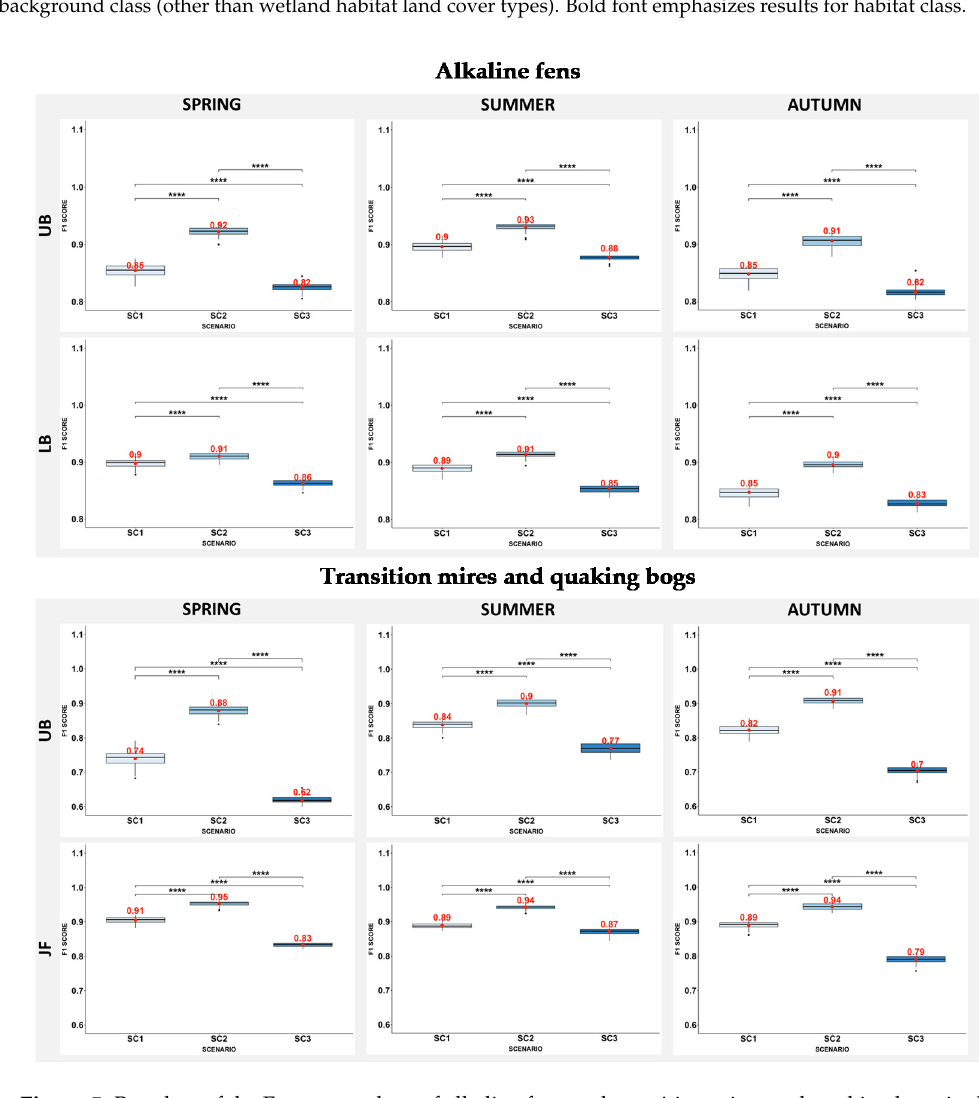
Figure 5. Boxplots of the F 1-SCORE values of alkaline fens and transition mires and quaking bogs in the UB, LB, and JF areas divided into the campaigns corresponding to the period of the growing season. Each box includes the median (central line), mean (red font), the 25th and 75th percentile (the edges of the box), extreme data points (whiskers), outliers (dots), and statistical significance